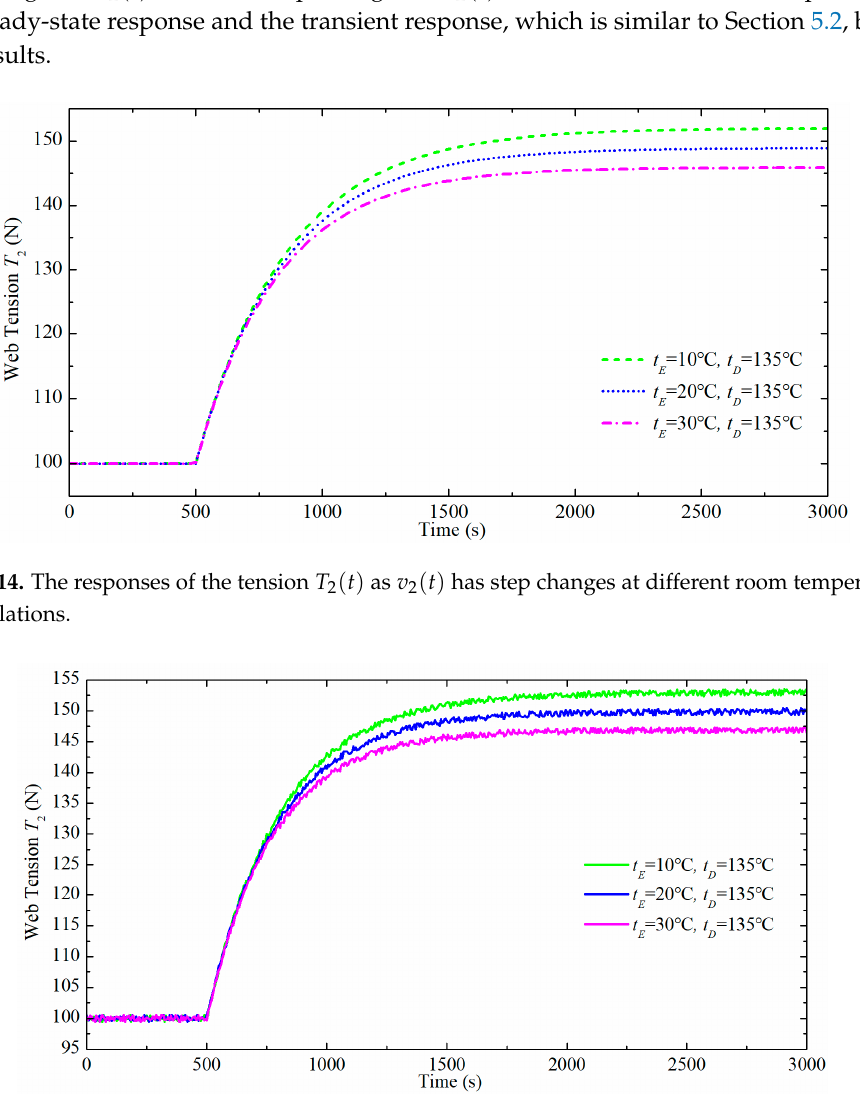
Figure 15. The responses of the tension T 2 ( t ) as v 2 ( t ) has step changes at different room temperatures in experiments.